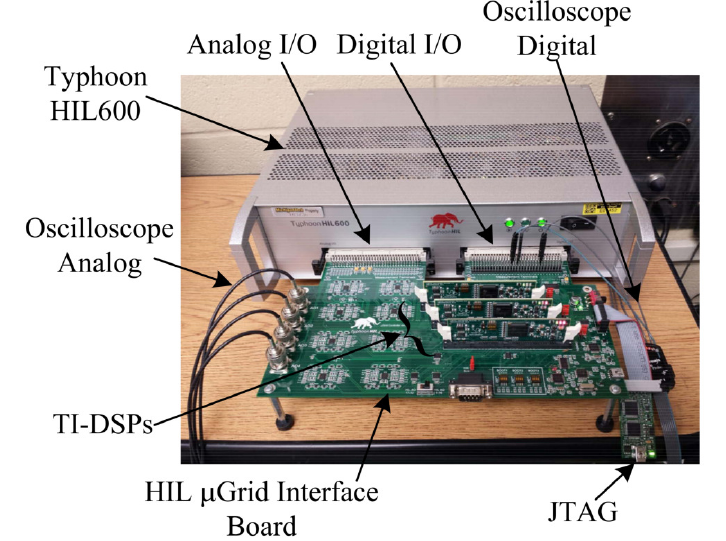
Figure 9. Typhoon HIL600 with microgrid control board and three TI-F28335 DSP ControlCards (two cards were used for this